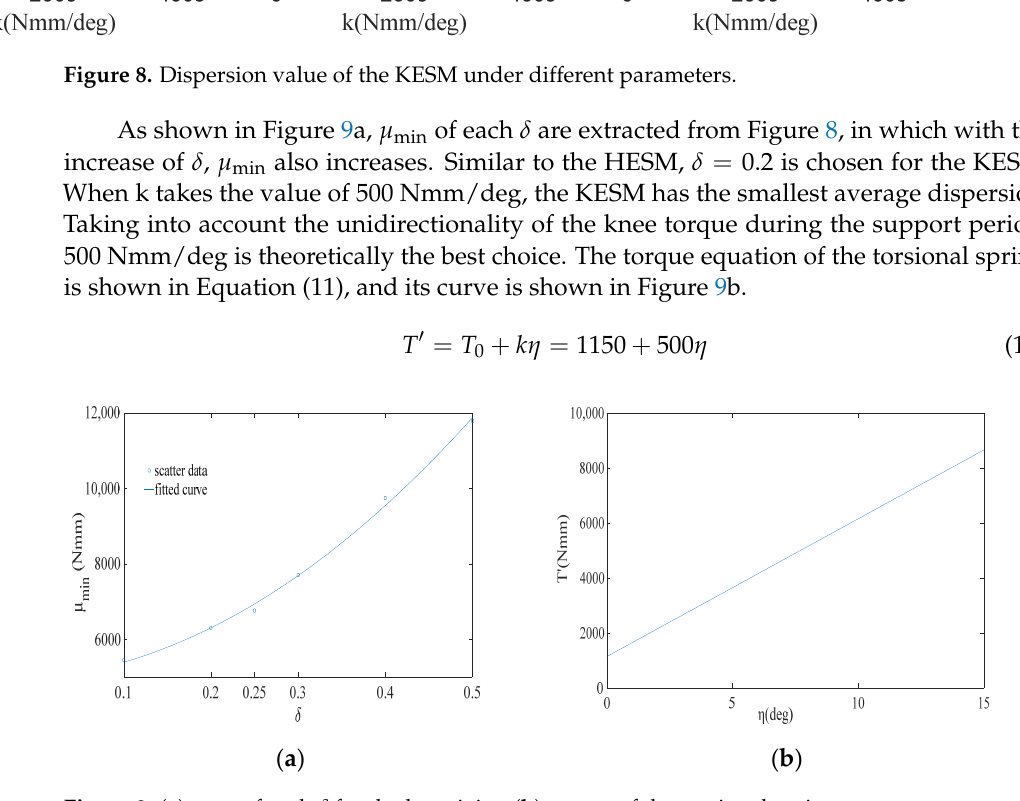
The influences of the elastic parameters of the energy storage components and the key structures of the exoskeleton for the exoskeleton were analyzed, and the optimal pa ‐ rameter combinations were selected for the HESM and the KESM respectively. Due to the lack of objective comparative conditions among all exiting exoskeletons, the effect of the cooperativity model on the exoskeleton was indicated by comparing the walking ‐ assis ‐ tance efficiencies of the exoskeletons with the same structure but with different elastic parameters of the energy storage components. The exoskeletons with the optimal param ‐ eter combinations were selected as the experimental group of the cooperativity model, and the exoskeletons with other parameter combinations were selected as the reference group. The exoskeletons with different design parameters were subjected to dynamic sim ‐ ulation to verify the validity of the cooperativity model. In addition, to ensure the objec ‐ tivity and rationality of the simulation results, this paper refers to the simulation strategy adopted by another paper [17]. 5.1. Effect of the Cooperativity Model on the HESM To test the influence of different parameter combinations on the exoskeleton, this pa ‐ per appropriately adjusted the analysis results in Section 3, selected 200 N and 400 N for the initial force, and 10 N/mm, 25 N/mm and 40 N/mm for the stiffness. The joint powers with the exoskeletons with different parameter combinations are shown in Figure 10, where F (N) represents the initial pressure of the pressure spring and K (N/mm) repre ‐ sents the stiffness of the pressure spring. Based on Figure 10, in most regions of the whole gait cycle, it is obvious that the joint power with the exoskeleton is smaller than without the exoskeleton. Specifically, in the part area of the joint negative work, the decrease of the joint powers conforms to the walk ‐ ing ‐ assistance characteristics of the exoskeleton. However, it must be affirmed that in the areas of the joint positive work in region A, the joint power increases instead, which con ‐ forms to the strategy adopted by the exoskeleton design for the transition uncertainty con ‐ cerning the positive and negative work. It is worth noting that there is one anomalous issue that does not conform to the understanding of this paper. There is a positive work area near 1.1 s—the joint positive work in the collection area of the joint negative work violates the design principle of the mechanism [4,22,32]. This phenomenon, which is ab ‐ normal compared with the public data, needs to be further considered.